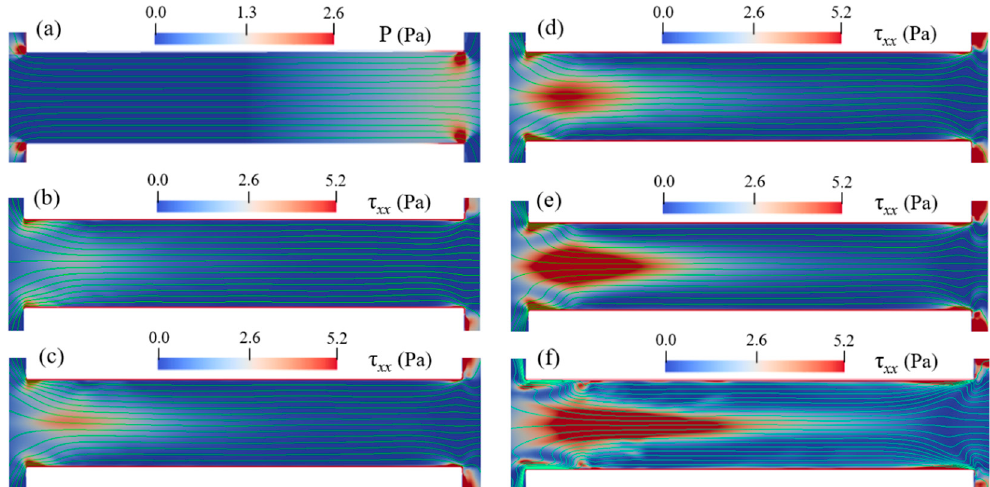
Figure 12. Streamlines in microchannel of Newtonian fluid and PAA solutions with different concentrations under E app = 600 V/cm at 1.7 s: ( a ) Newtonian fluid, ( b ) c p = 100 ppm, ( c ) c p = 150 ppm, ( d ) c p = 200 ppm, ( e ) c p = 250 ppm, and ( f ) c p = 500 ppm. The color bar represents the elastic normal stress τ xx